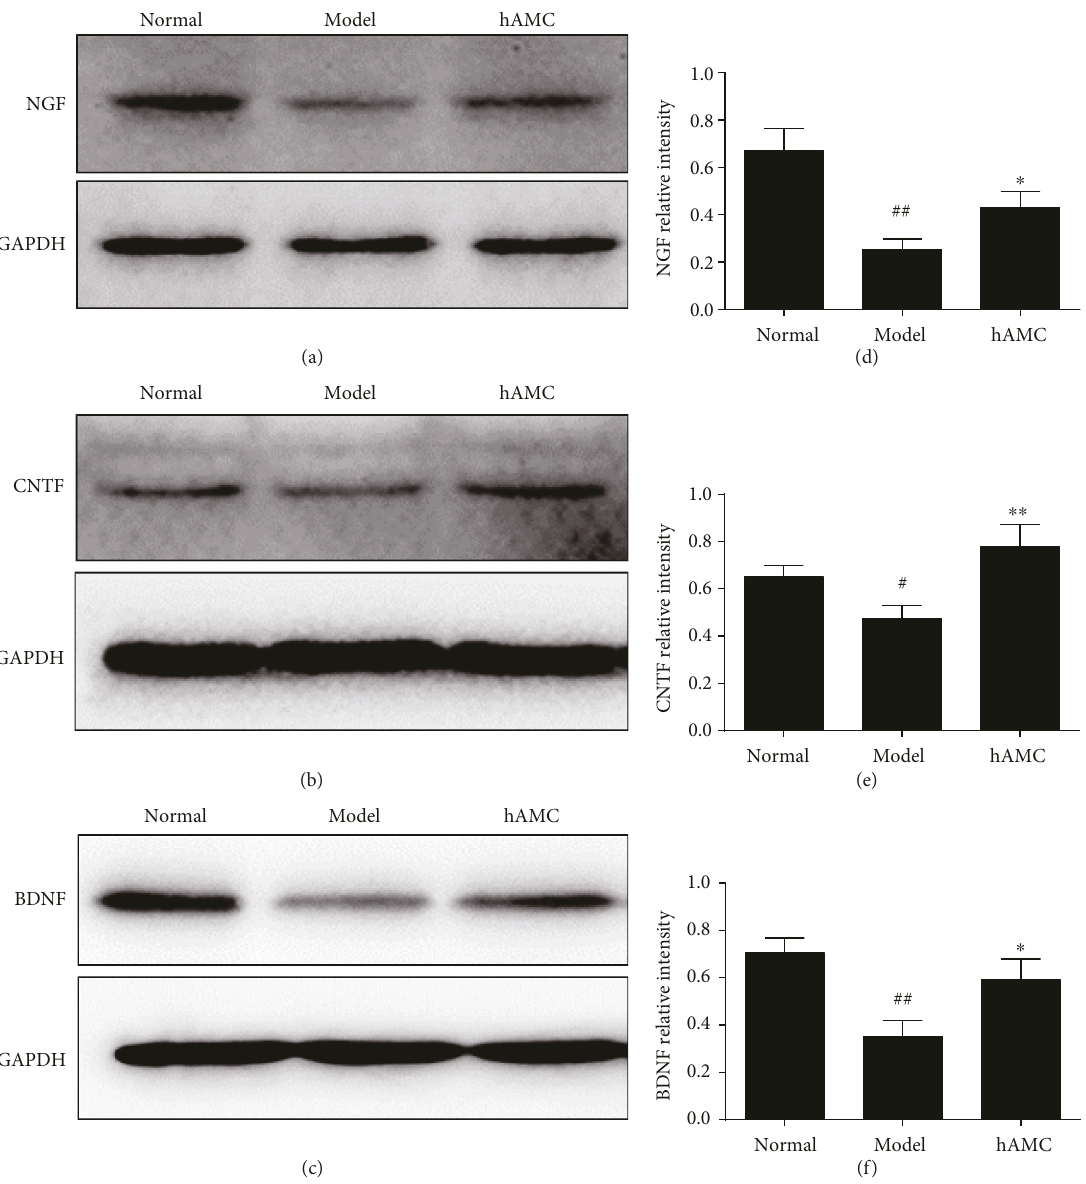
Figure 5: hAMC increases the neuron-repair factors in the CNS of EAE mice. (a – c) Representative images. (d – f) The quantitative analysis. The levels of NGF, CNTF, and BDNF in the brain were determined by Western blot. Data were mean ± SD. n = 8 mice per group. # P < 0 05 , ## P < 0 01 , compared to normal group. ∗ P < 0 05 , ∗∗ P < 0 01 , compared to model